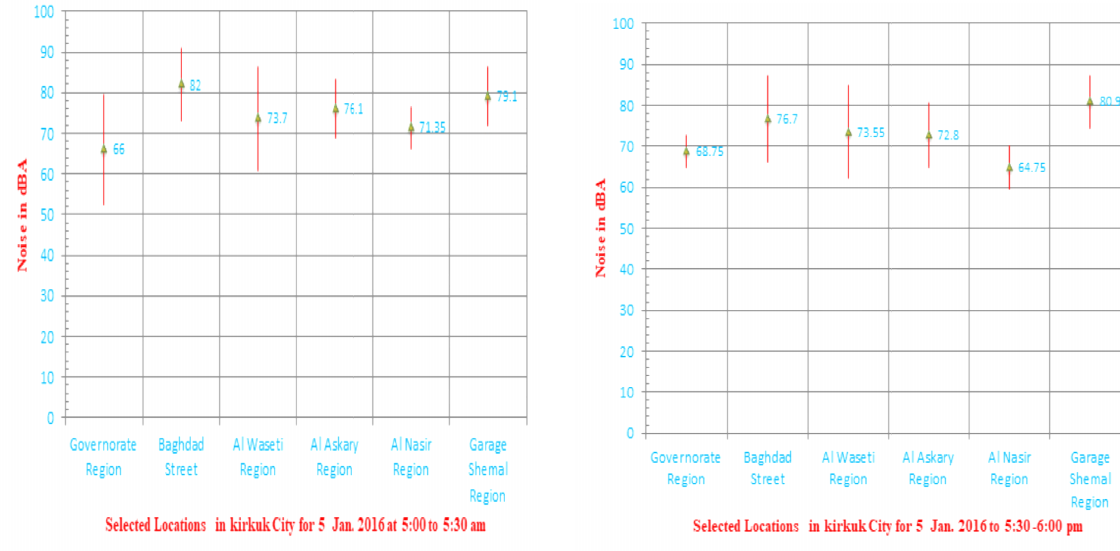
Fig. 15. Max, Min and Average Hourly Max, Min and Average Hourly Noise Distribution for the traffic flow 5 Jan. 2015 r the traffic flow 5 Jan. 2015 Kirkuk